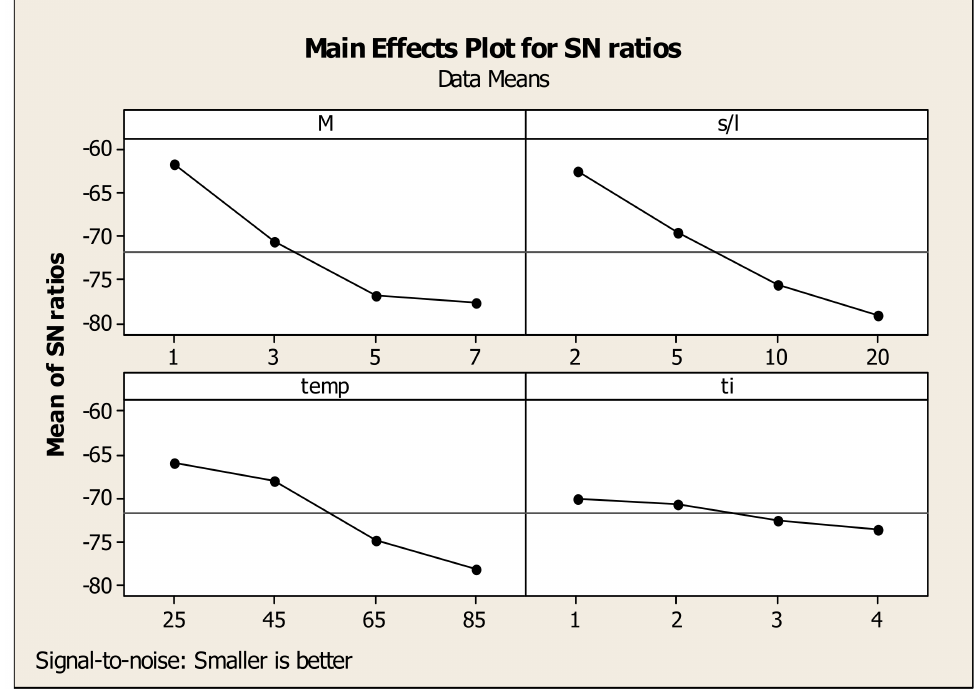
Figure 13. Effects of each factor associated with their levels on the statistical performance of S/N ratio for Fe